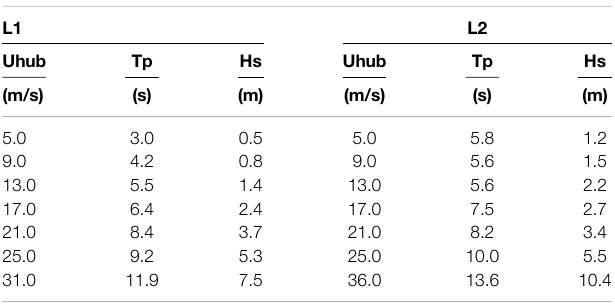
TABLE 3 | Met-ocean data at the two installation locations in the Mediterranean Sea and North Sea. L1